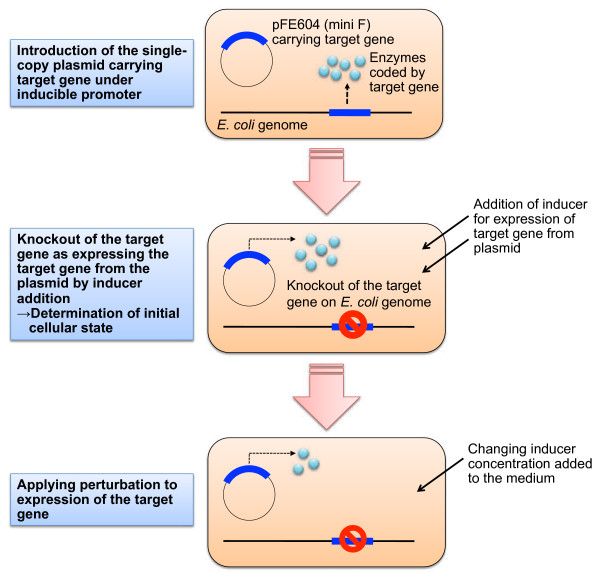
Construction of the gene expression-controllableE. colistrain. Details of the method for constructing the gene expression-controllable strain are described in the Results and Methods sections.